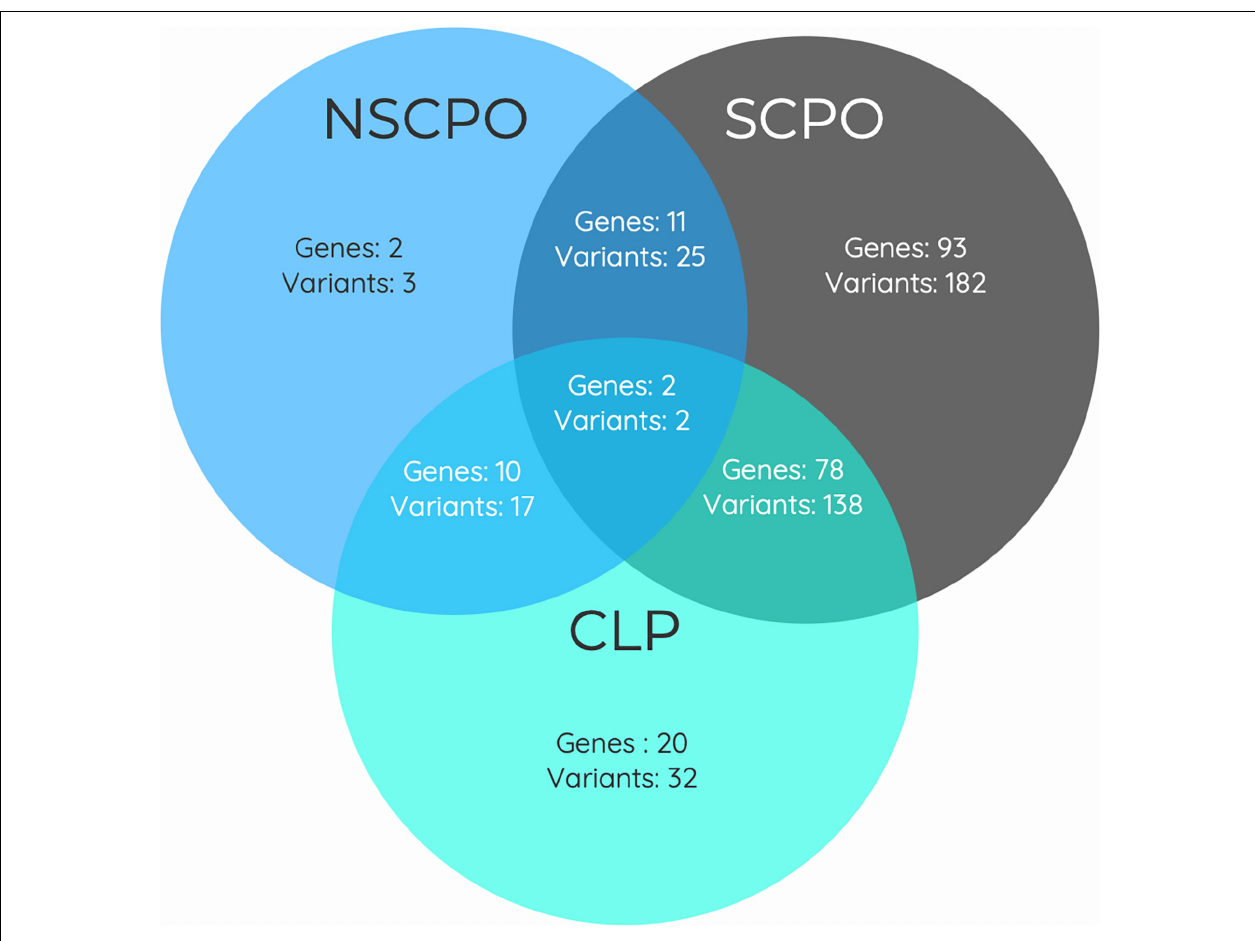
FIGURE 3 | Venn diagram showing the overlap between genes associated with the phenotypes of non-syndromic cleft palate only (NSCPO), syndromic cleft palate only (SCPO), and cleft lip and palate (CLP) found in patients with NSCPO. The numbers in each area represent the gene and variants count for the particular